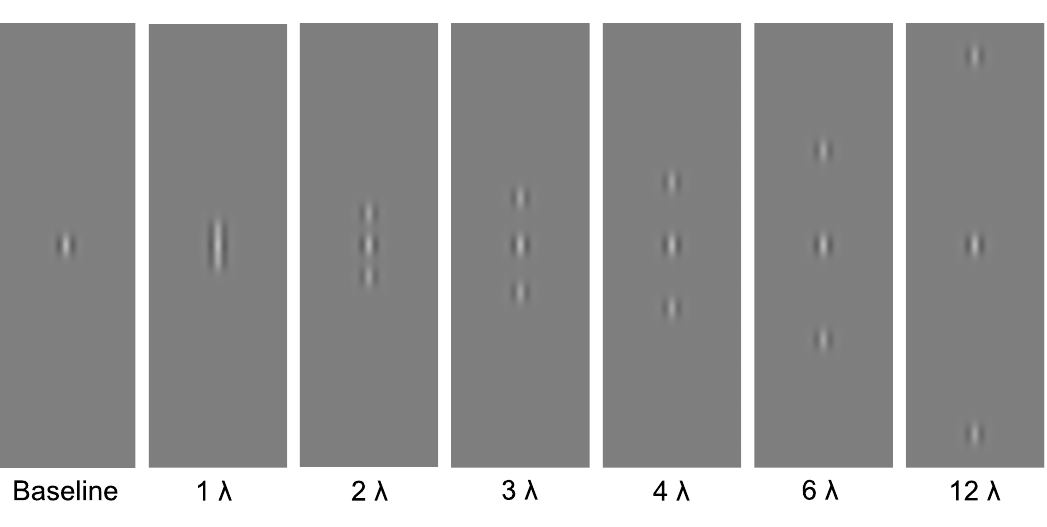
Figure 1. Experimental stimuli. Central Gabor target presented alone, and in the presence of high-contrast, high-spatial-frequency flanking Gabors at one of six distances (1 λ , 2 λ , 3 λ , 4 λ , 5 λ , 6 λ or 12 λ